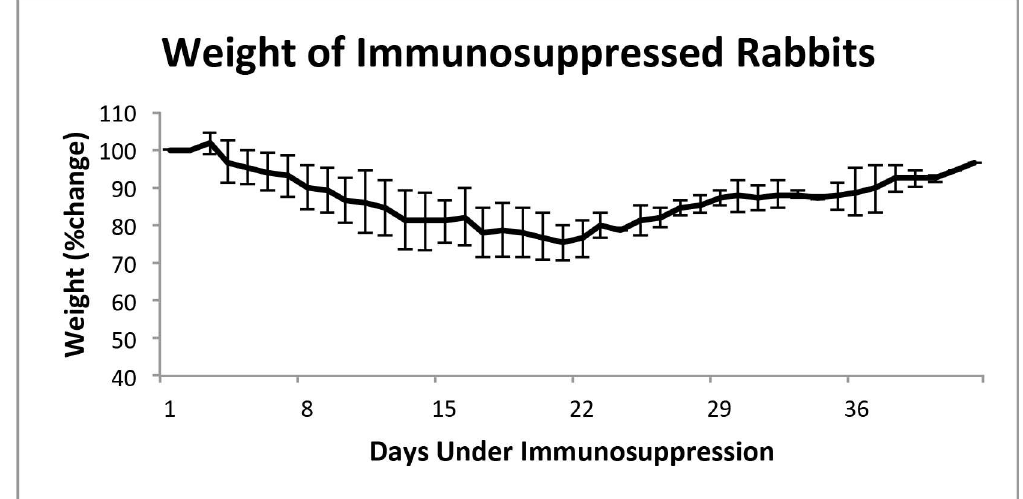
Fig 2. Body weight measurements over the course of immunosuppression.